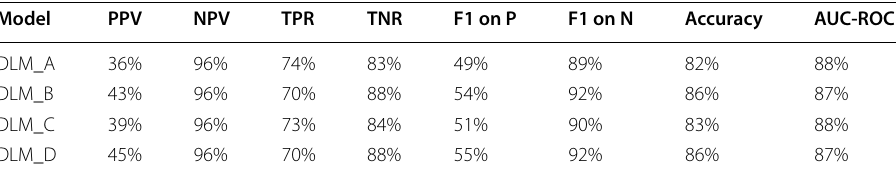
Table 15 Results: testing